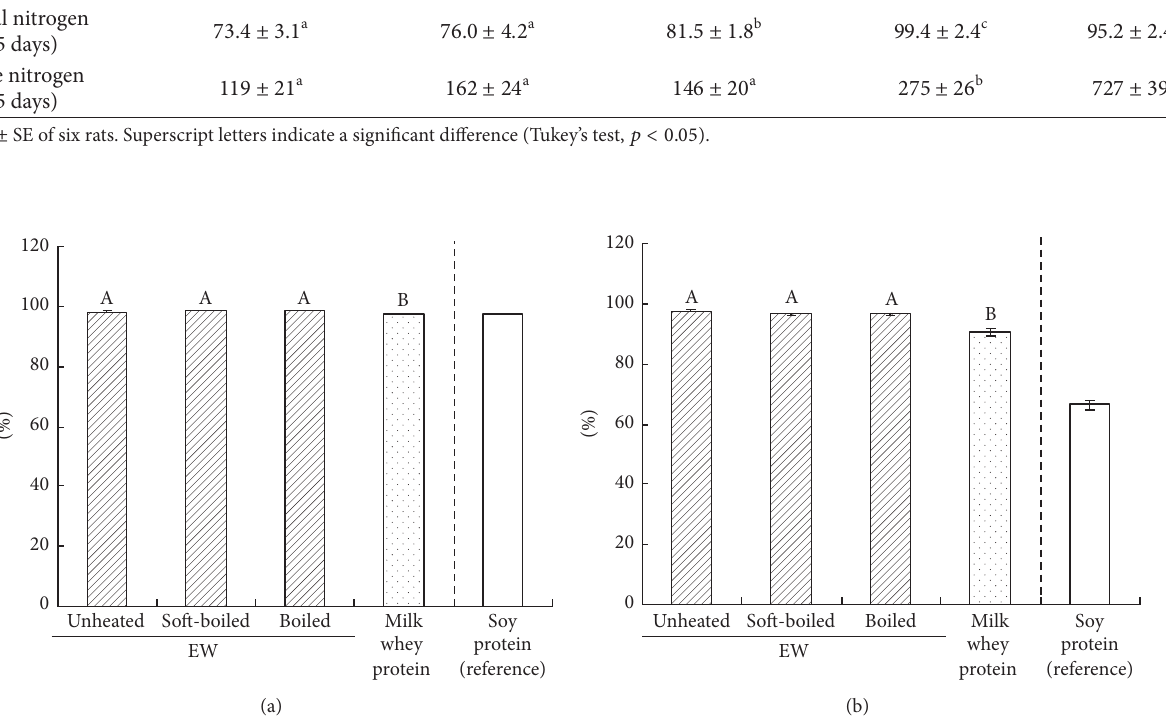
Figure 1: Digestibility (a) and net protein utilisation (b) of heat-treated egg white (EW) in rats. Mean ± standard error (SE) of six rats. Superscript letters indicate a significant difference (Tukey’s test, 𝑝 < 0.05